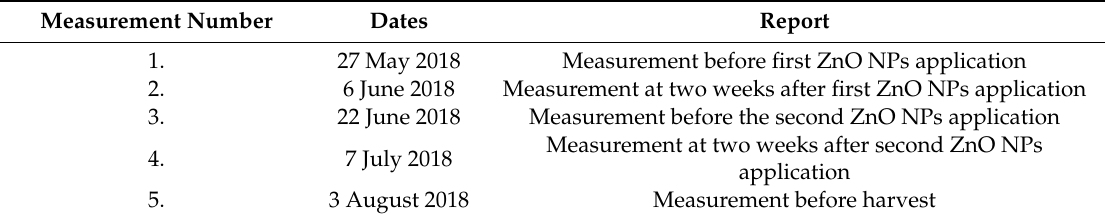
Table 2. Measurements of foxtail millet foliate crop water stress index (CWSI) in (1) foxtail millet foliate treated with zinc oxide nanoparticles (ZnO NPs) and (2) in controls; at di ff erent growth stages. Measurement Number